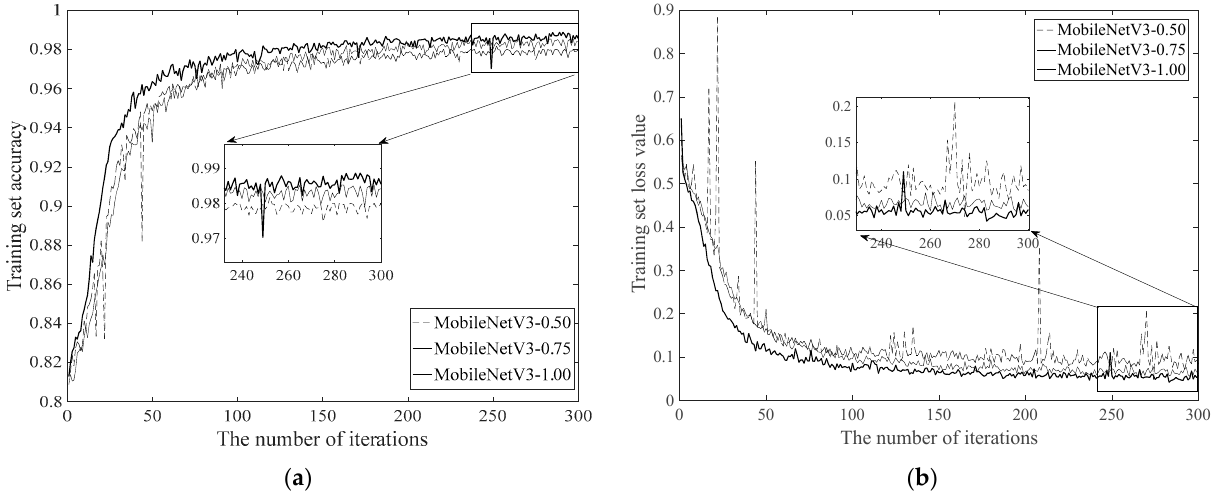
Figure 5. Comparison of loss values and accuracy for different-width multipliers based on the MobileNetV3 algorithm on Shanghai Hongqiao Airport dataset. ( a ) Accuracy comparison of different-width multipliers. ( b ) Loss value comparison of different-width multipliers.